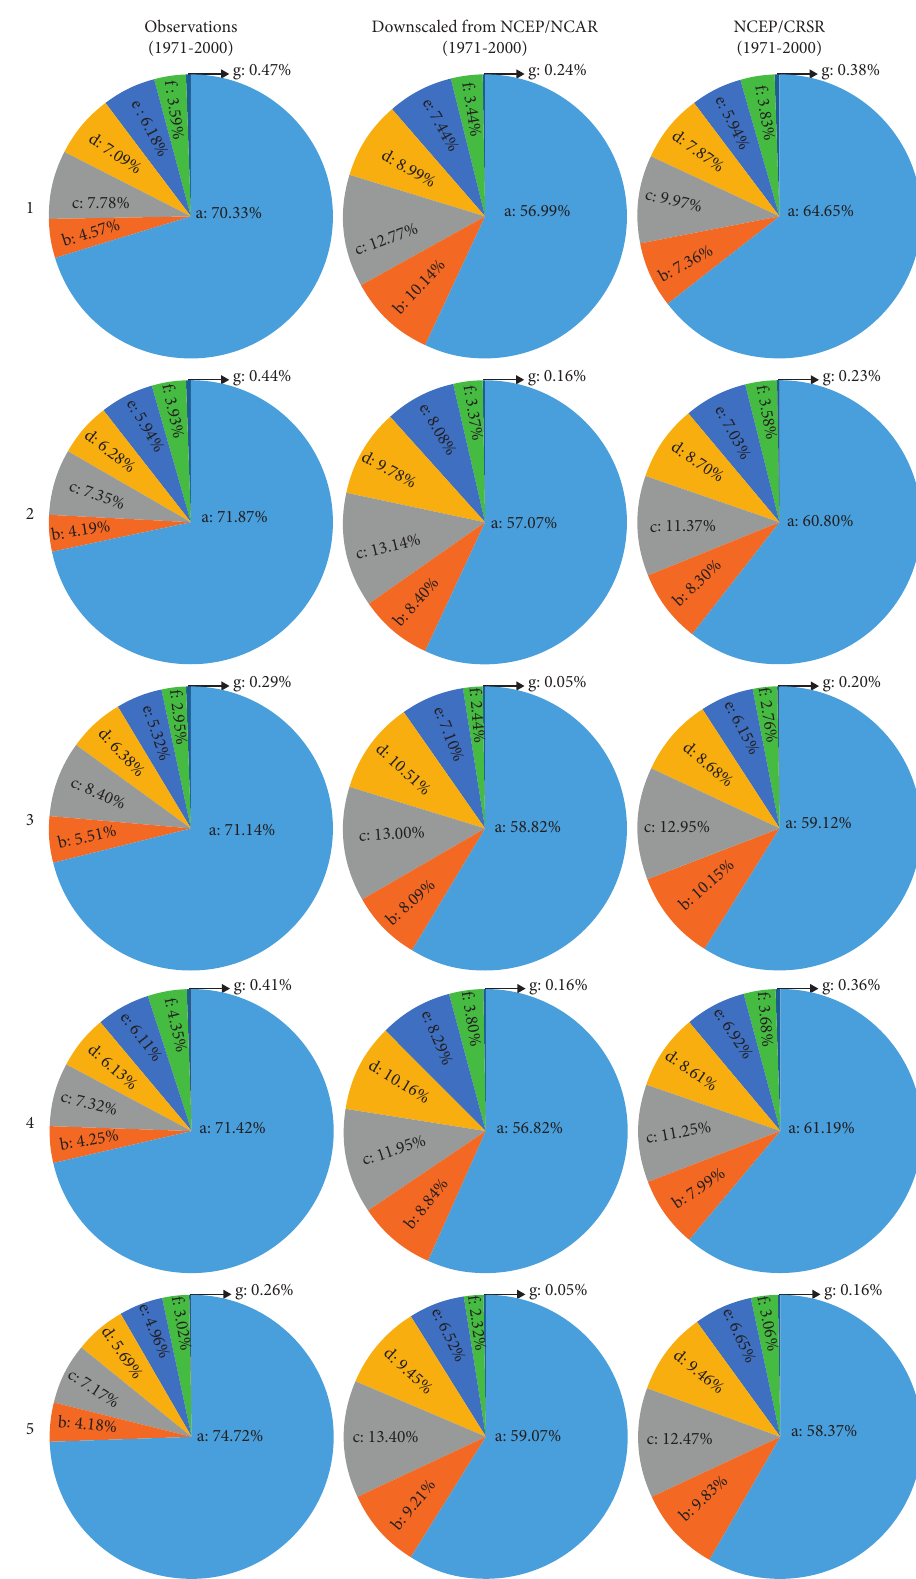
Figure 6: Frequency distribution of observed daily precipitation values and downscaled precipitation from the NCEP/NCAR and NCEP/ CFSR at selected nodes (Figure